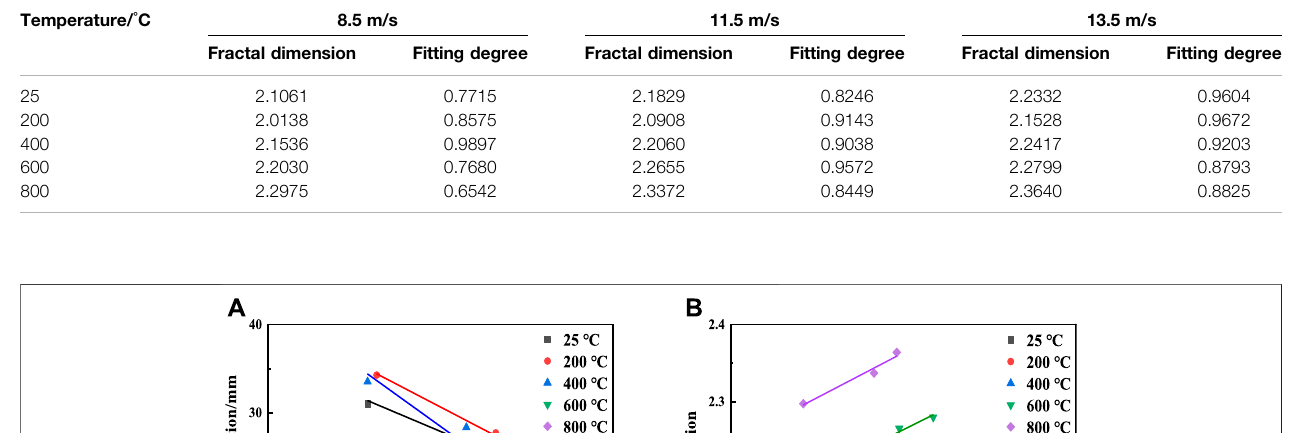
characterization indexes in the energy dissipation theory. Figure 10 shows the relationship among average fragmentation, fractal dimension, and energy consumption density.